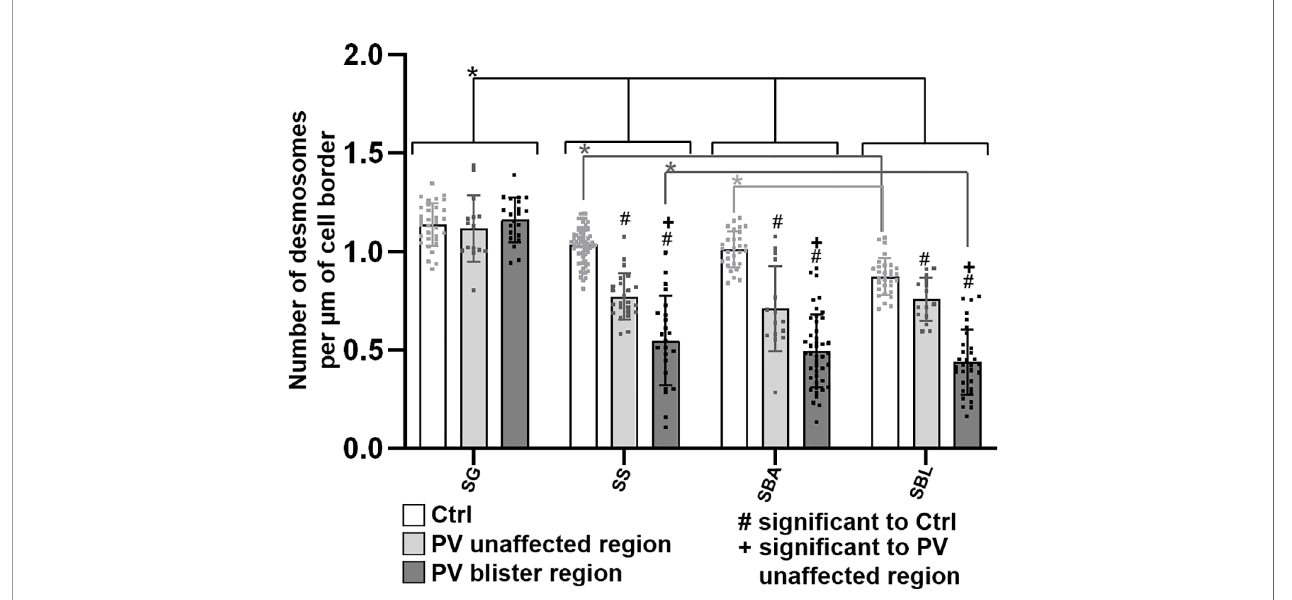
FIGURE 6 | Quanti fi cation of desmosomes per membrane length in pemphigus patient and control skin. N (patients) = 3, n (cell borders) =1-7. *Signi fi cant difference to the value which is indicated that it is compared